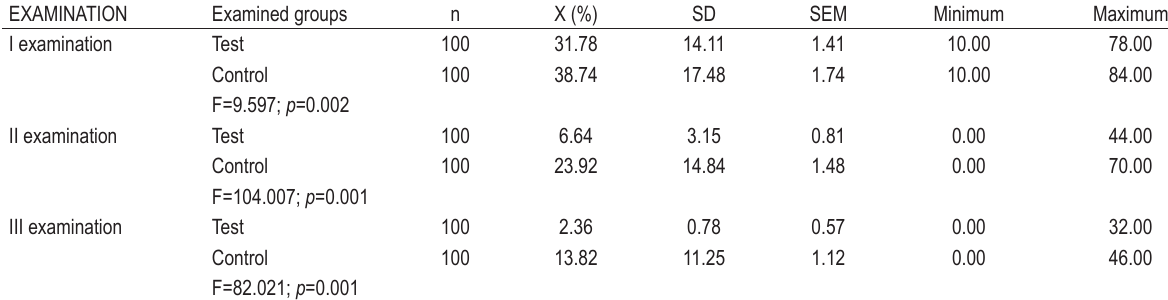
TABLE 7. Analysis of the disability percentage in both examined